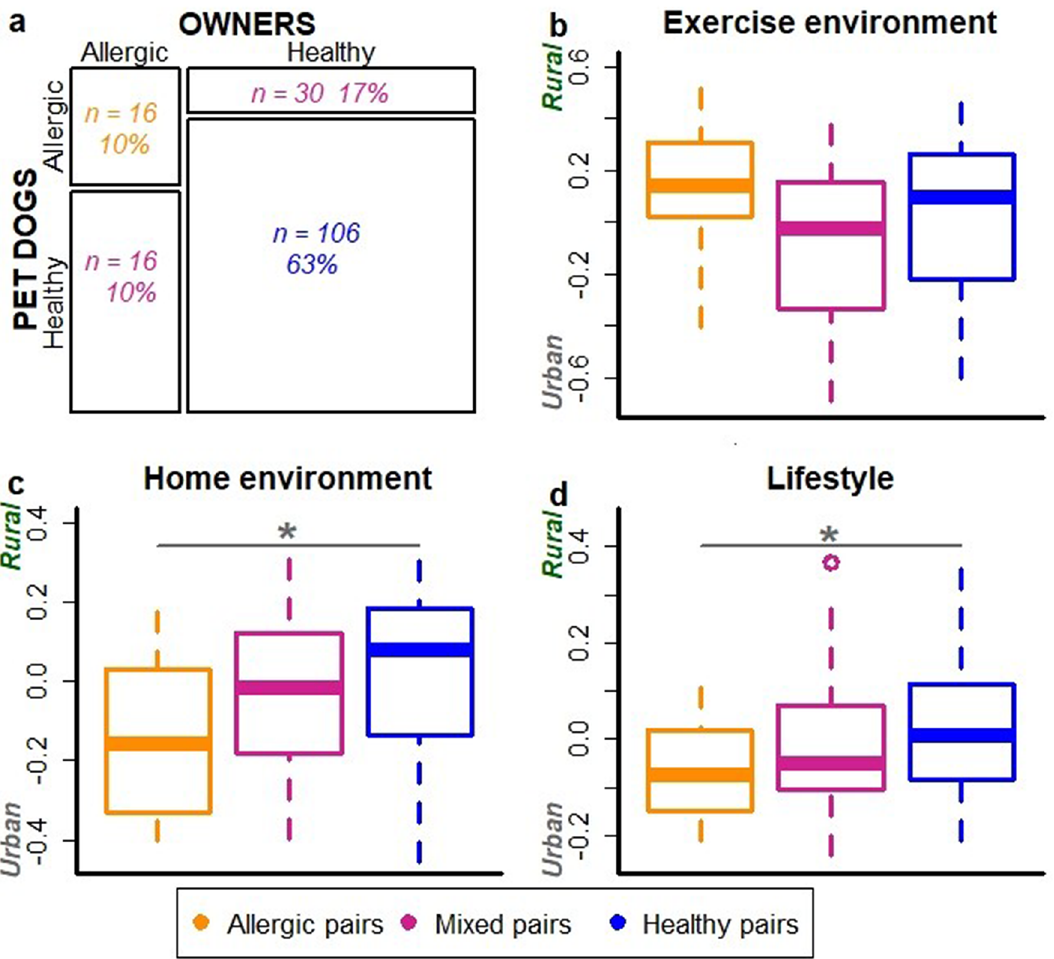
Figure 2. Dogs and their owners tend to be allergic or healthy concurrently. The proportion of allergic, healthy and mixed i.e. mixed dog-owner pairs in the data ( a ). The association of exercise environment ( b ), living environment ( c ) and lifestyle ( d ) with dog-owner groups. Decreasing values on y-axis indicate higher urbanization of exercise and living environment as well as more urban lifestyle. Living environment was significantly more urbanized in allergic than healthy dog owner pairs (ANOVA, p = 0.010). Additionally, lifestyle was more urban in allergic compared to healthy dog-owner pairs (p =